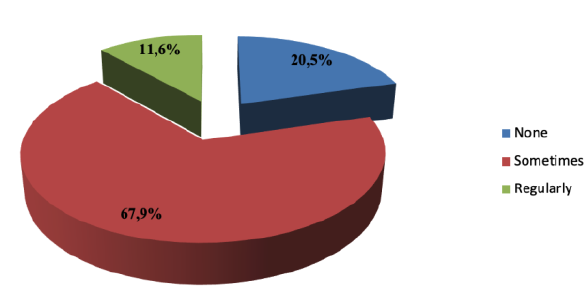
Figure 1: Times that the Respondent has benefited from Government